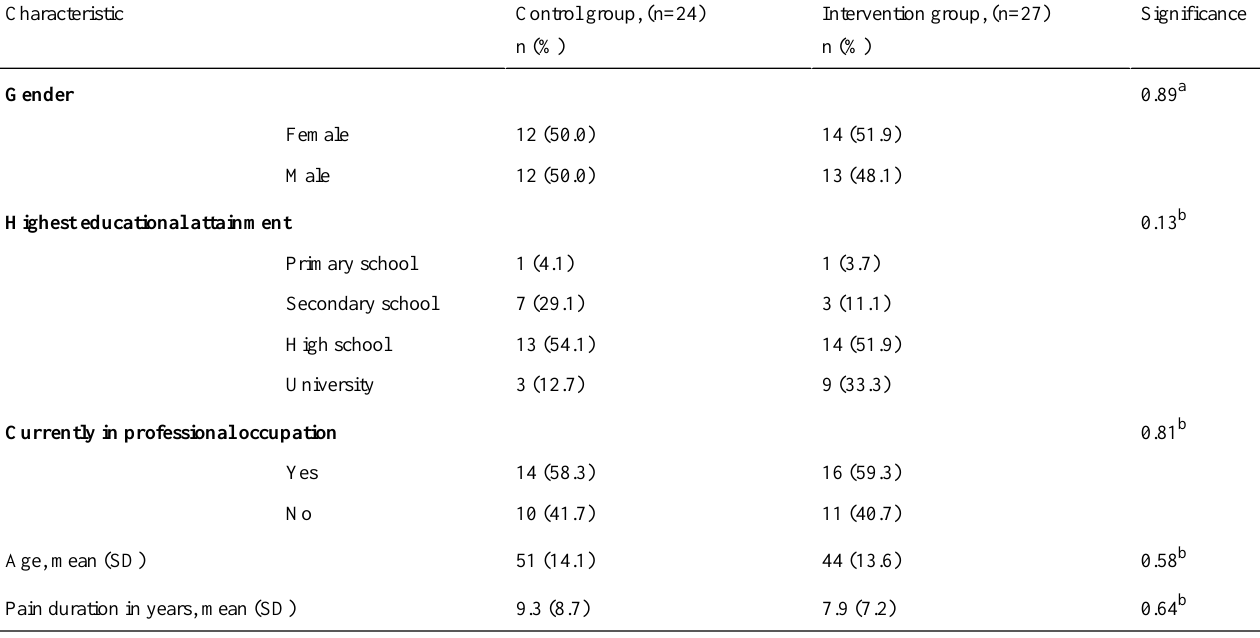
Table 1. Sociodemographic characteristics of participants at baseline assessment.